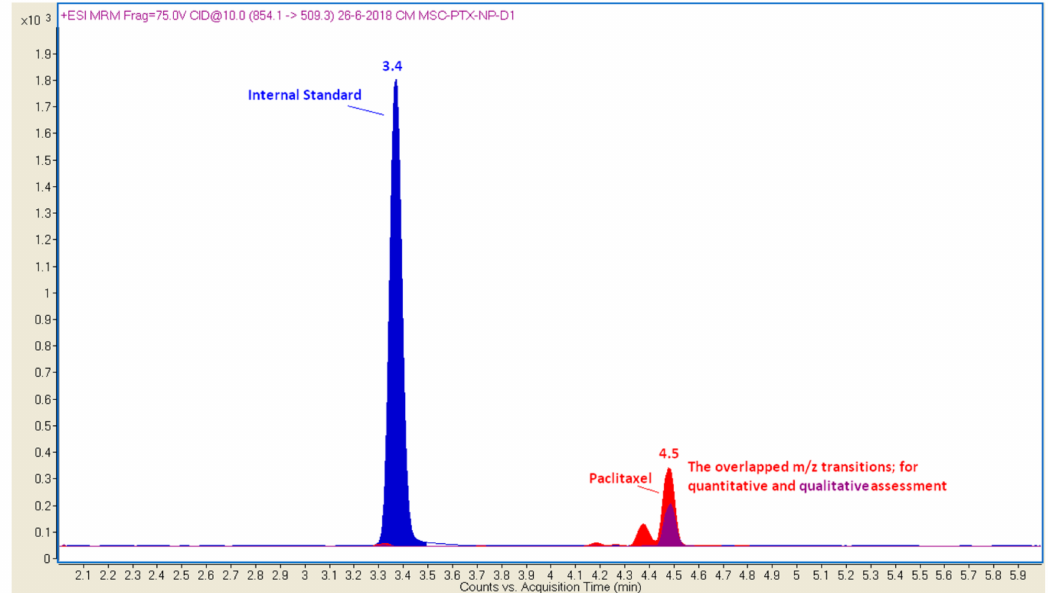
Figure 2. Representative SRM profiles for PTX drug free in a real sample obtained by loading the drug in silk fibroin-based nanoparticles. X-axis: retention time (minutes); Y-axis: signal